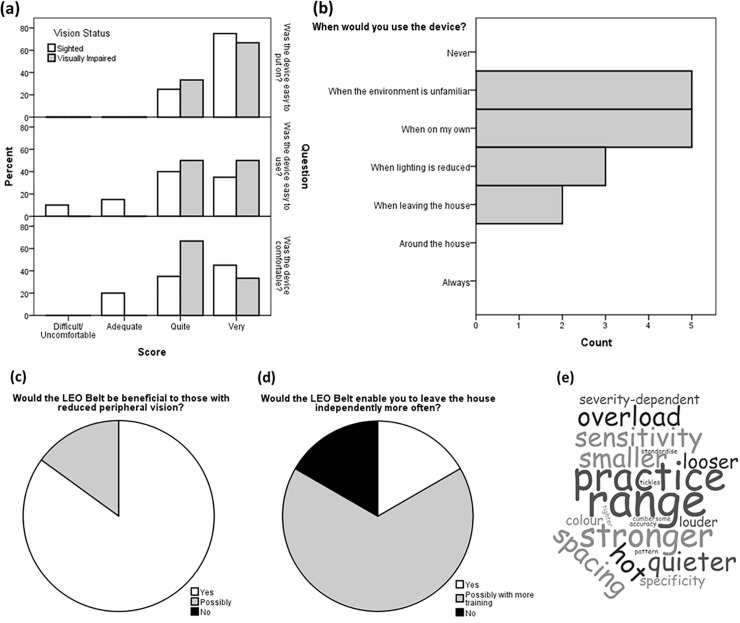
Questionnaire feedback.Questionnaire responses revealed user opinions and suggestions for improvements following using the LEO Belt. Opinions were collected from both sighted (white) and visually impaired (grey) subjects on ease to wear, use and comfort of the device (a). Visually impaired subjects were also asked if they owned the device when they would use it (b). Sighted and visually impaired subjects were both asked their views on the future usefulness of the device to others (c) or themselves (d) respectively. All subjects offered suggestions to improve the LEO Belt, shown in a word cloud (e).